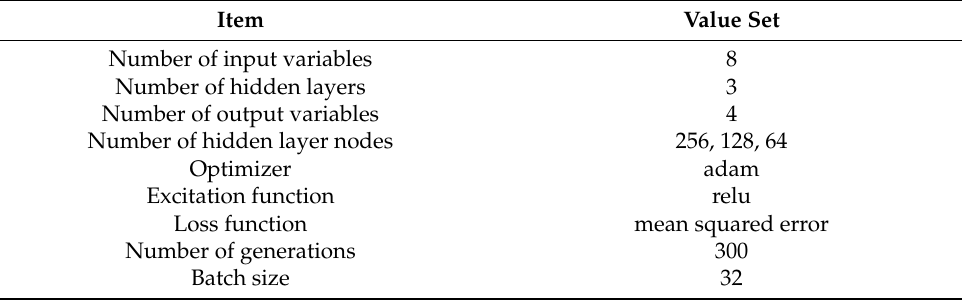
Table 13. LSTM neural network hyper-parameters and architecture-related settings.